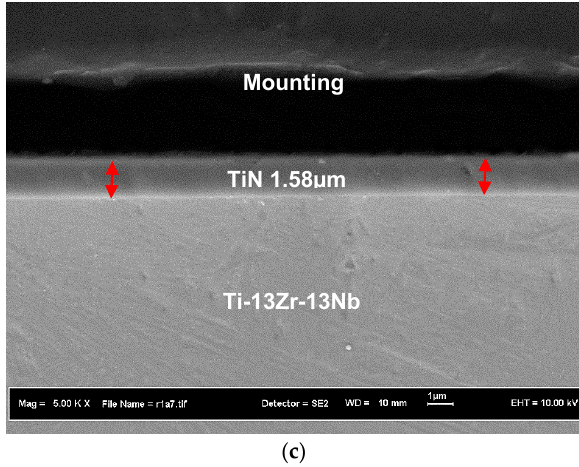
Figure 2. Cross-sectional view of TiN ( a ) before ultrasonic treatment, untrasonic treatment at ( b ) 8 kHz and ( c ) 16kHz.